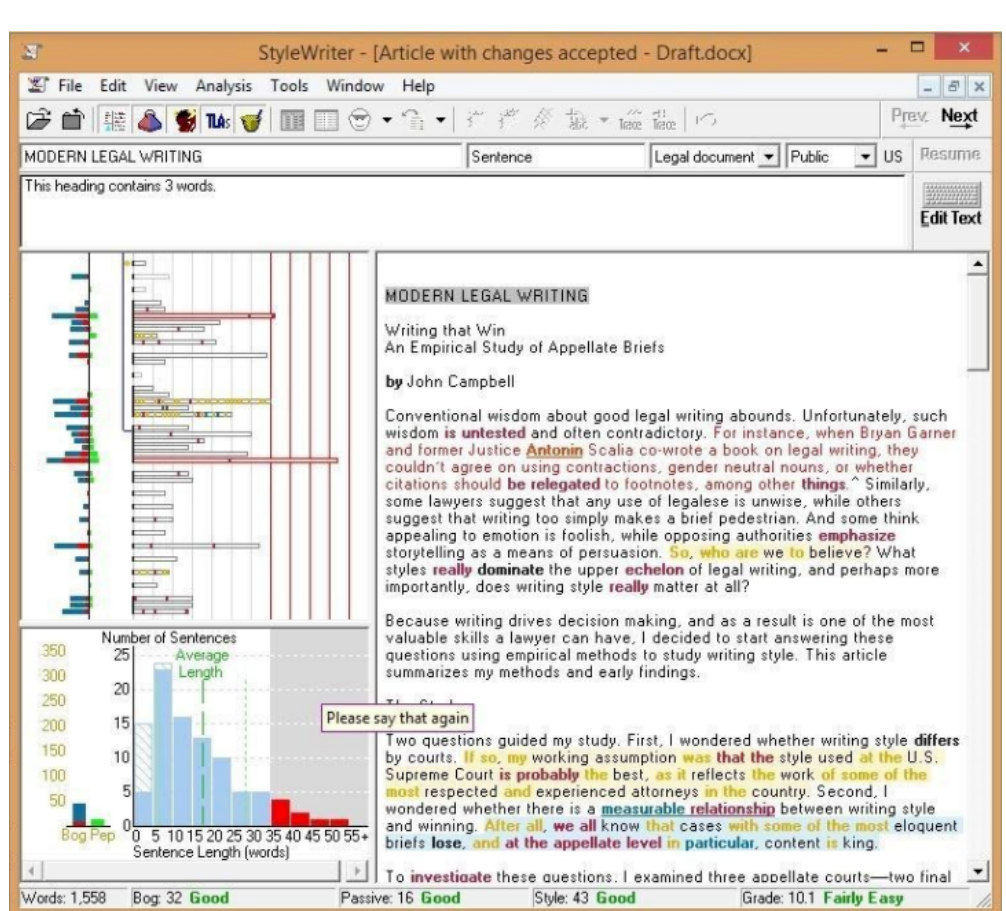
Figure 1: StyleWriter 4, Standard Edition developed by Editor Software Ltd